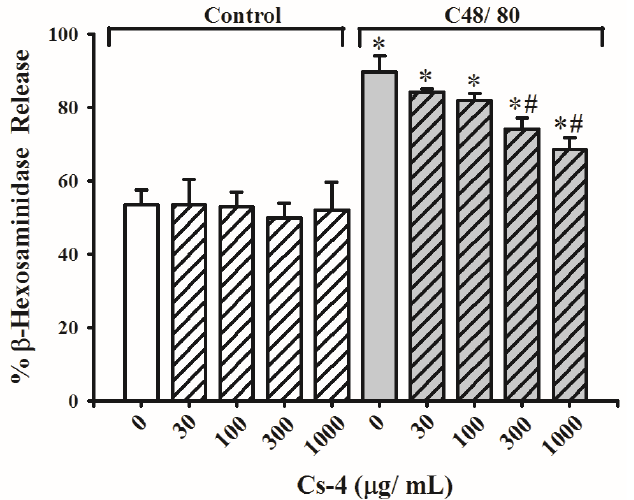
Figure 3. The effect of Cs-4 on ( a ) the levels of interleukin (IL)-4 and ( b ) IL-13 in the NLF of OVA- sensitized and challenged mice. Each bar represents the mean ± S.E.M., with n = 5. * Significantly different from the non-OVA control group. # Significantly different from the OVA-sensitized and challenged control group.